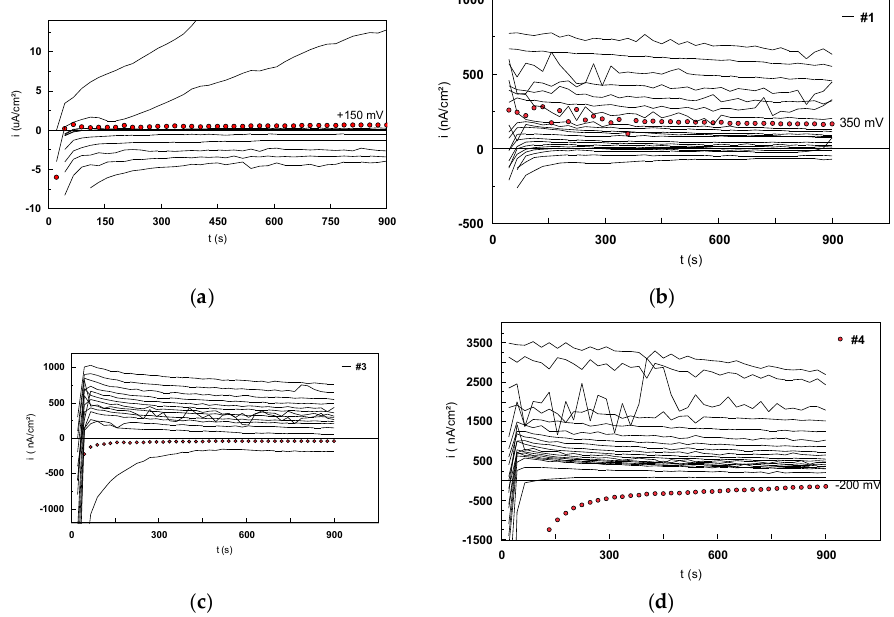
Figure 19. Polarization current densities recorded for different alloys, during 15 min, at preselected potentialsand above E oc , in a solution of 9 g / L NaCl: ( a ) 316L alloy [43] and Ti-based alloys: ( b ) #1, ( c ) #3 and ( d ) #4.